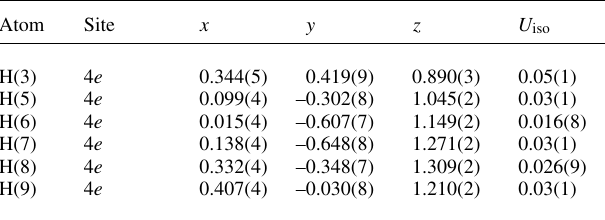
Table 2. Atomic coordinates and displacement parameters (in Å 2 )